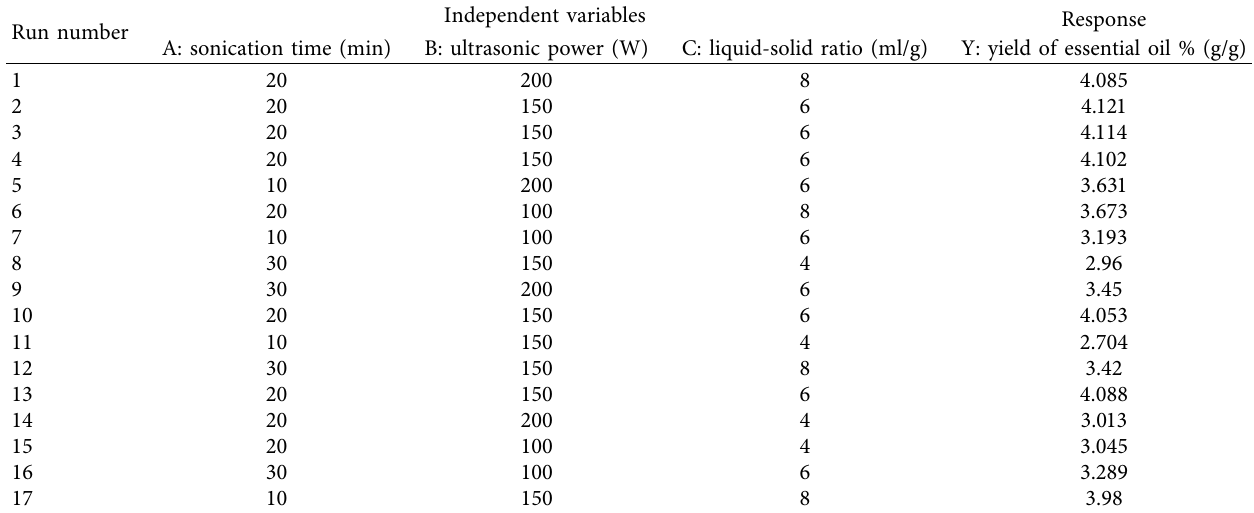
Table 2: The design matrix of BBD and yield of essential oil.